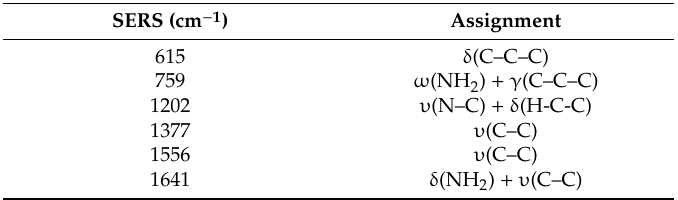
Table A1. Assignment of Vibrational Bands in SERS Spectra of Safranin O.